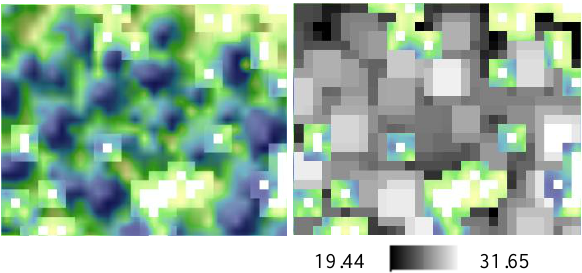
Figure 10. Height values greater than or equal to 5 m (left) and the maximum values in a 3 m x 3 m cell (right)